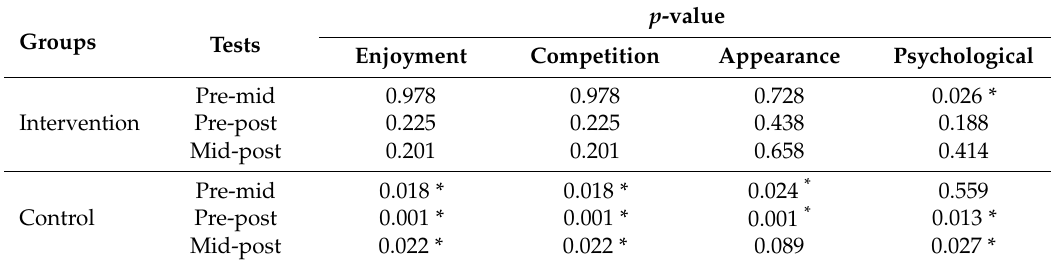
Table 4. Post-hoc for motive subscales of enjoyment, competition, appearance, and psychological